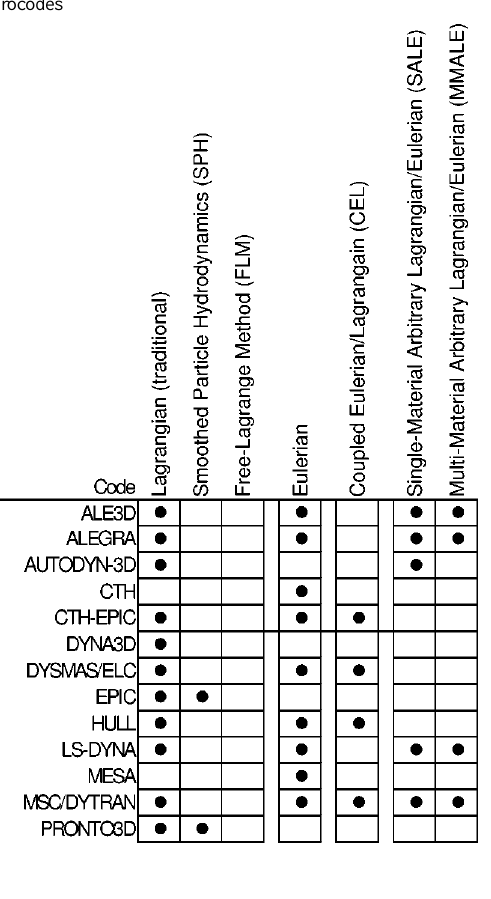
Descriptions and potential SMI applicabilities of prominent 3D